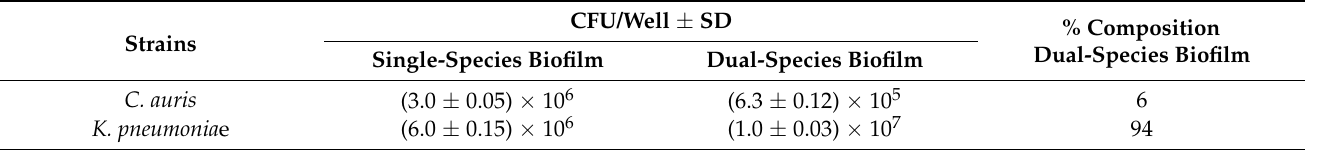
Figure 2. Characterization of single- and dual-species biofilm at 24 h with crystal violet ( a ) and XTT ( b ); Horizontal red line indicated ODc (ODcut = mean of negative control with addition of 3 times the SD). Table 2. Characterization of single- and dual-species biofilm at 24 h.